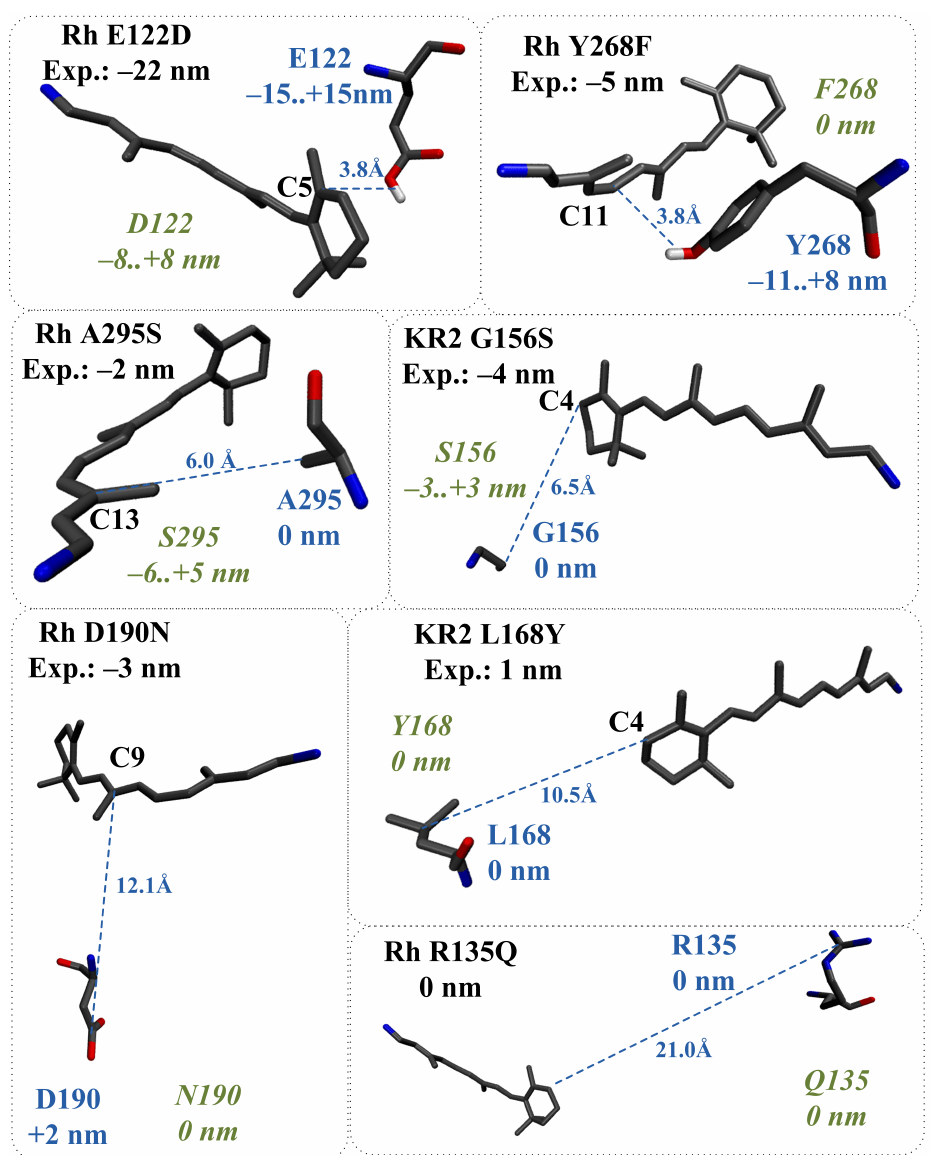
Figure 8. Bovine rhodopsin (Rh) and sodium pumping rhodopsin (KR2) mutants, for which the direct effect of amino acid substitution completely explains the experimentally observed spectral shift. Experimental spectral shift values are shown in black. The distances from the wild-type residues to the PSB and corresponding contributions to λ max are shown in blue. The evaluated contributions of new residues to λ max are shown in green. The distances are given in